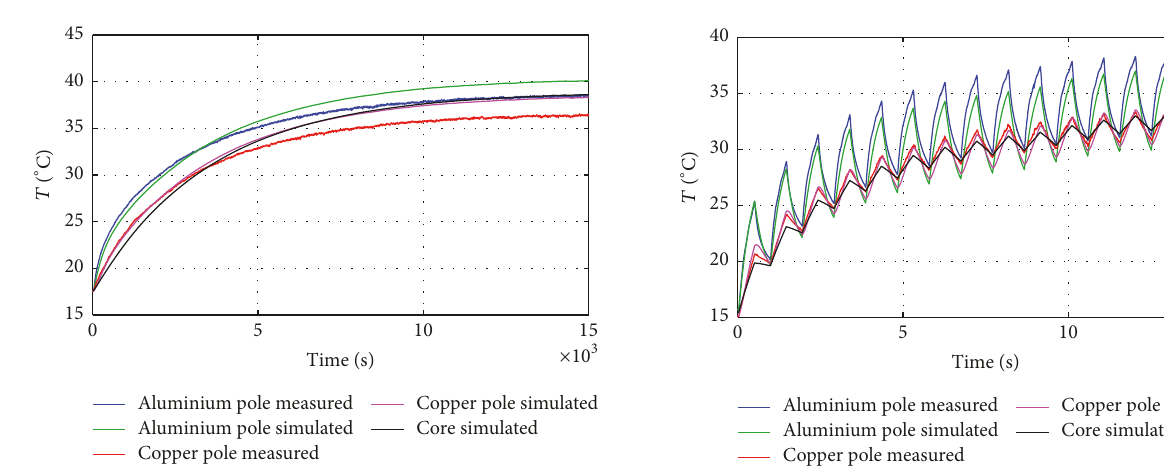
Figure 10: Model output and system output comparison for 2nd set of measurements with the tuned parameters.